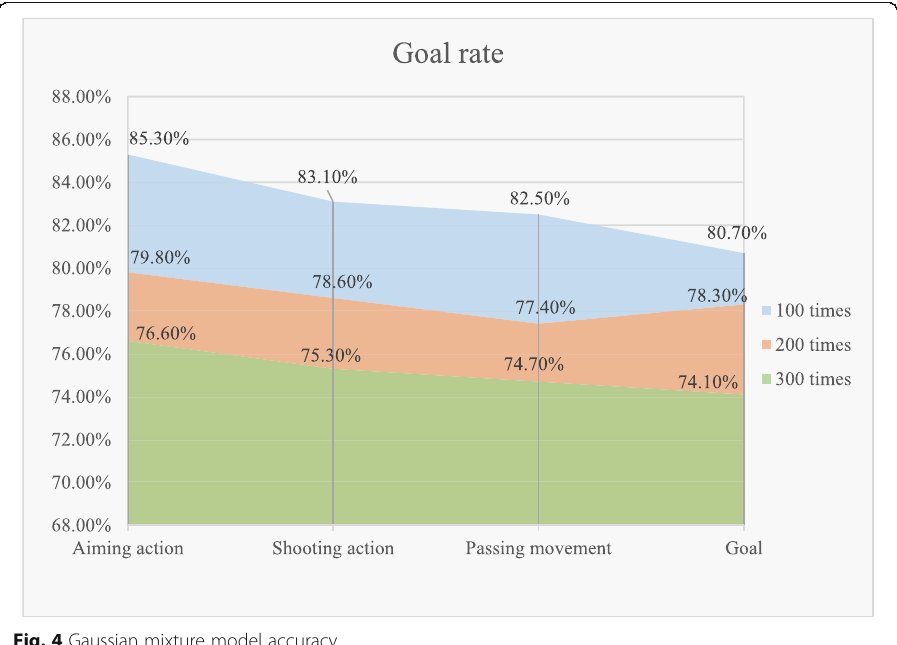
Fig. 4 Gaussian mixture model